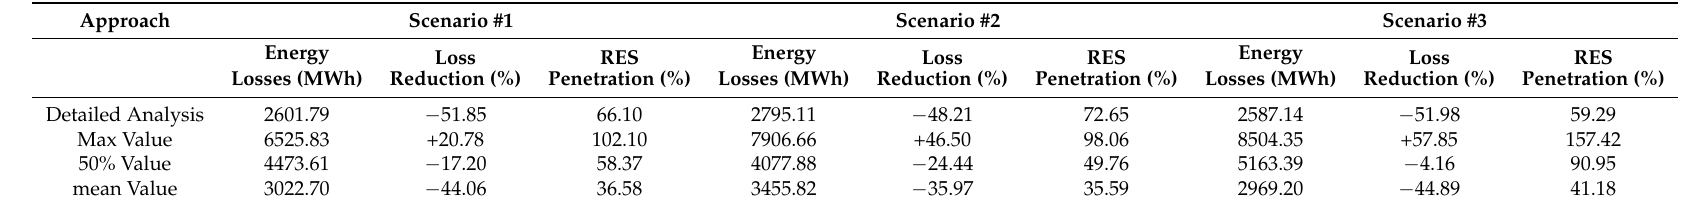
Table 21. comparison of snapshot approach with detailed